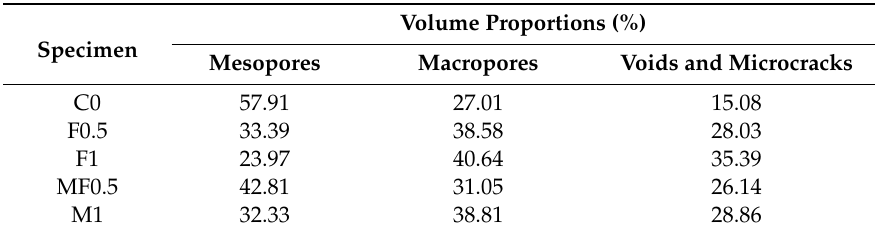
Table 2. Proportion by volume of pore structures in cement specimens.